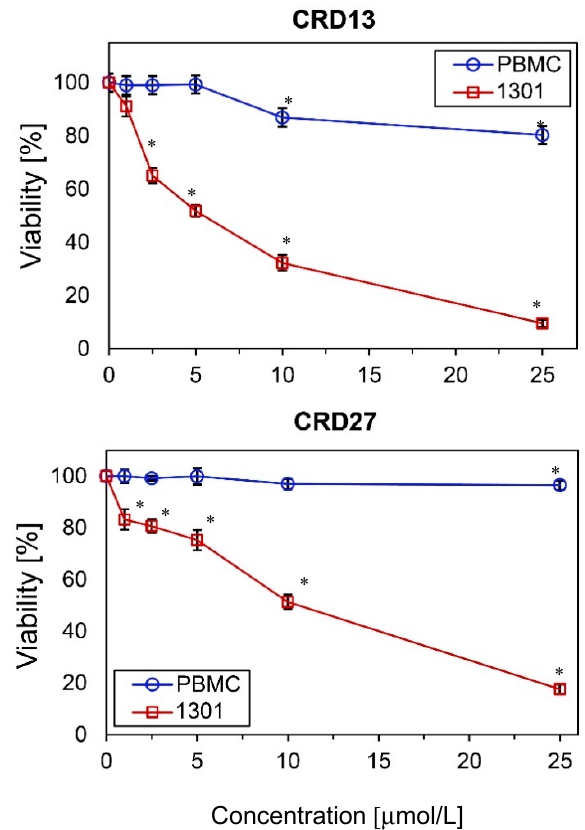
Figure 1. The e ff ect of ruthenium-terminated carbosilane dendrimers (CRD) on viability of peripheral blood mononuclear cells (PBMCs) and 1301 cells after 24 h treatment. The values are mean ± SD of n > 6. * Statistically significant di ff erences compared to the control cells (* p < 0.05). Table 1. Inhibitor concentrations (IC 50 ± SD (µmol/L)) resulting in 50% dendrimer-mediated reduction of 1301 cell viability.